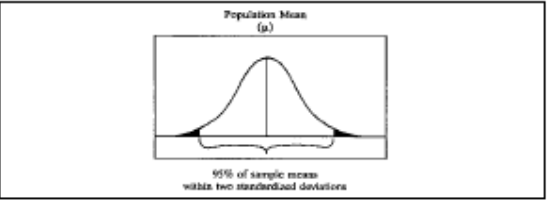
Figure 2. Cochran sample size